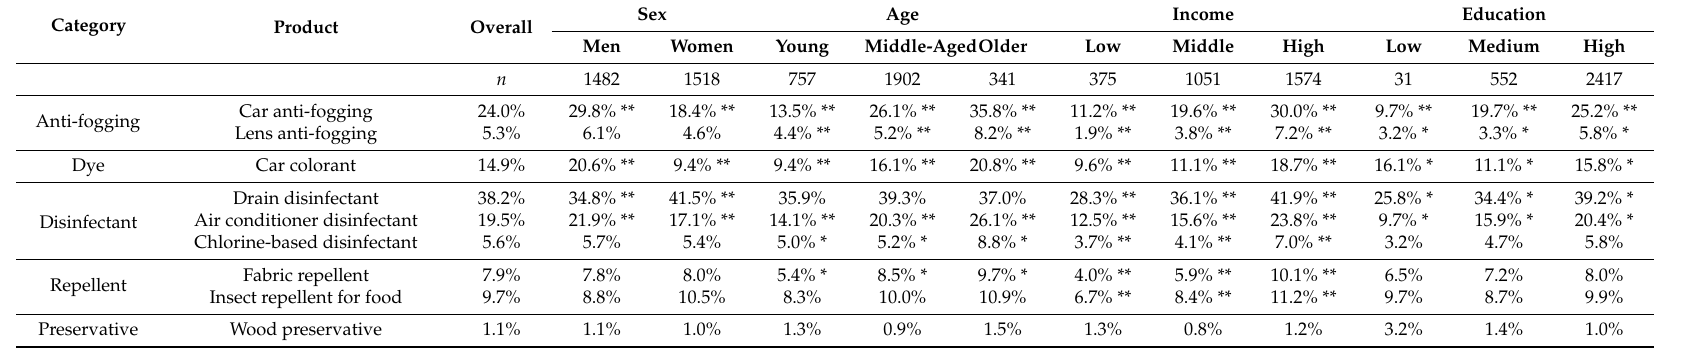
Table 2. Use of risk-concerned products (%) stratified by sex, age, income, and education